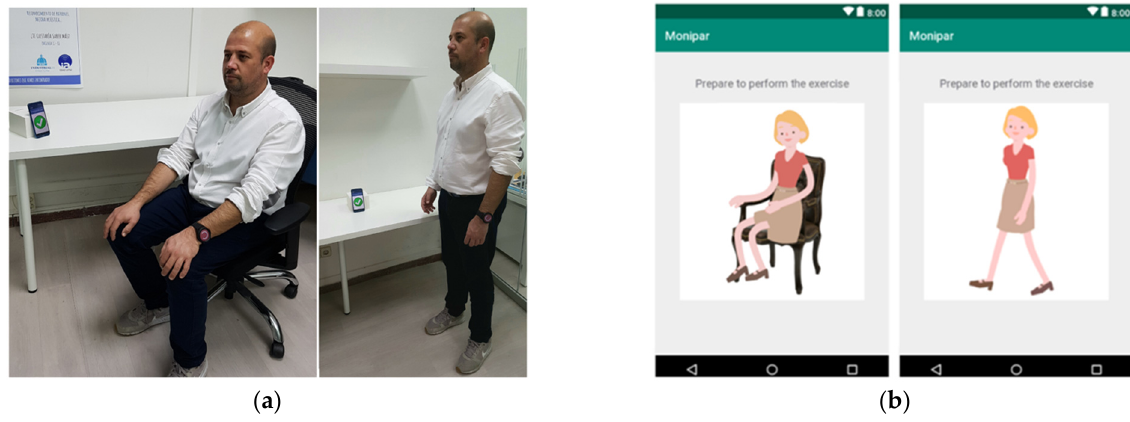
Figure 3. ( a ) Evaluation tests and data acquisition based on a smartwatch. ( b ) Mobile application.